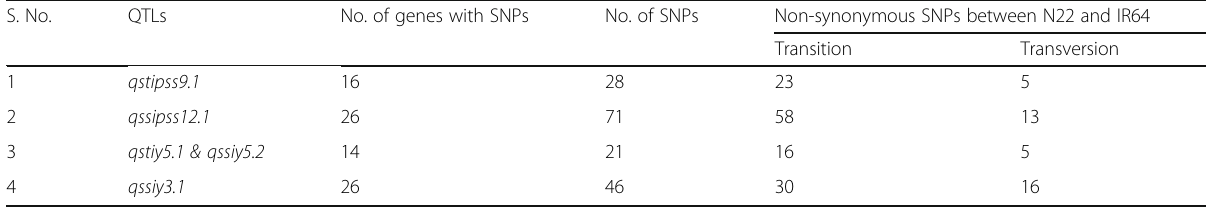
Table 6 Non-synonymous SNPs between N22 and IR64 in the mapped QTL region for heat stress tolerance S. No.